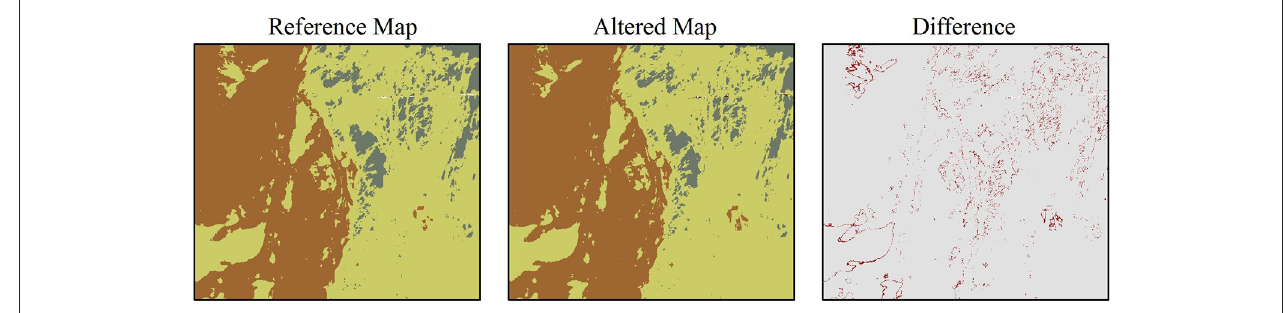
FIGURE 3 | Example of how using data of different quality can produce different outcomes. The reference map is the same as in Figure 2 . The altered map used bathymetric data impacted by artifacts caused by a 0.25s mis-synchronization in the surveying system (see Lecours et al., 2017a). The presence of artifacts made the classification vary of 2.1%. Motion artifacts, which are often present in bathymetric data, can cause much more impacts in mapping outcomes than time artifacts.